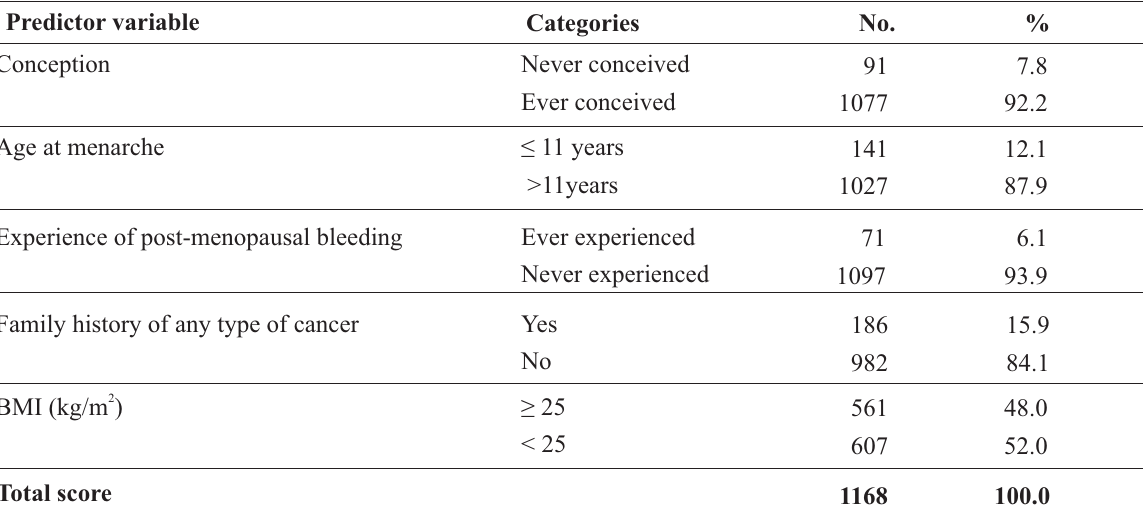
Table 3: Distribution of predictor variables in the risk prediction model among the study population Predictor variable